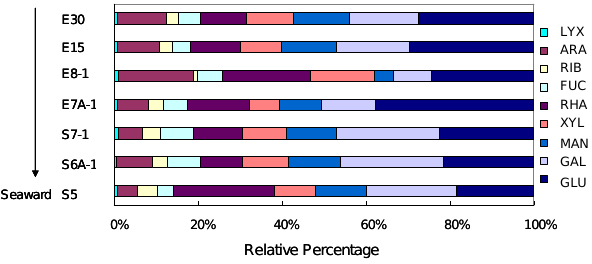
Fig. 5. Normalized distribution of monosaccarides in surface sed- iments collected from Lingdinyang Bay and the shelf of the South China